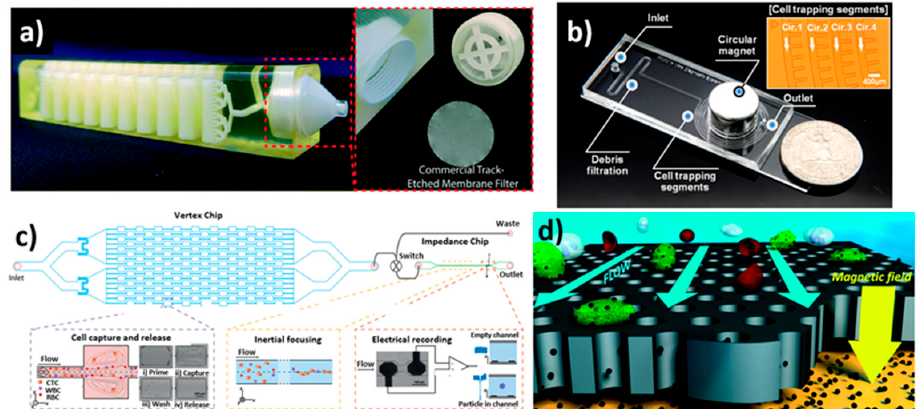
Figure 2. Microfluidic device designs fabricated using various techniques. ( a ) 3D-printed device showing the microchannels with layers and the filter holder; reprinted with permission from ref. [79], 2019, Royal Society of Chemistry. ( b ) Microfluidic device fabricated by photolithography showing spiral channel and cell trapping segments; reprinted with permission from ref. [89], 2018, Elsevier. ( c ) Representation of label-free enumeration of CTCs using a vortex chip connected to an impedance cytometry chip; reprinted with permission from ref. [95], 2019, John Wiley and Sons. ( d ) Schematic of the detection strategy of the micro-aperture chip system for CTC detection; reprinted with permission from ref. [96], 2015, Royal Society of Chemistry.